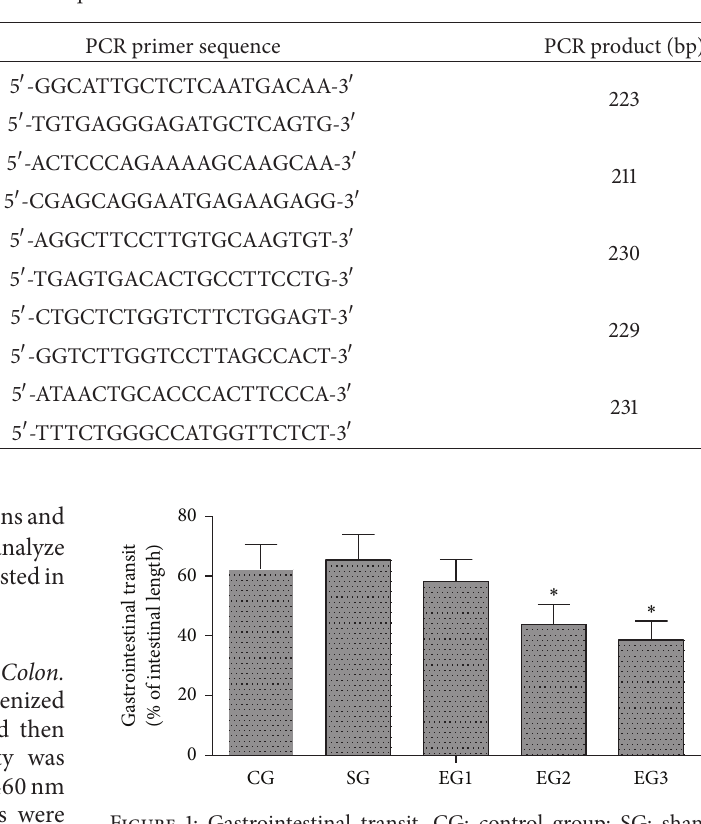
Table 1: The primer sequences used for RT-PCR.